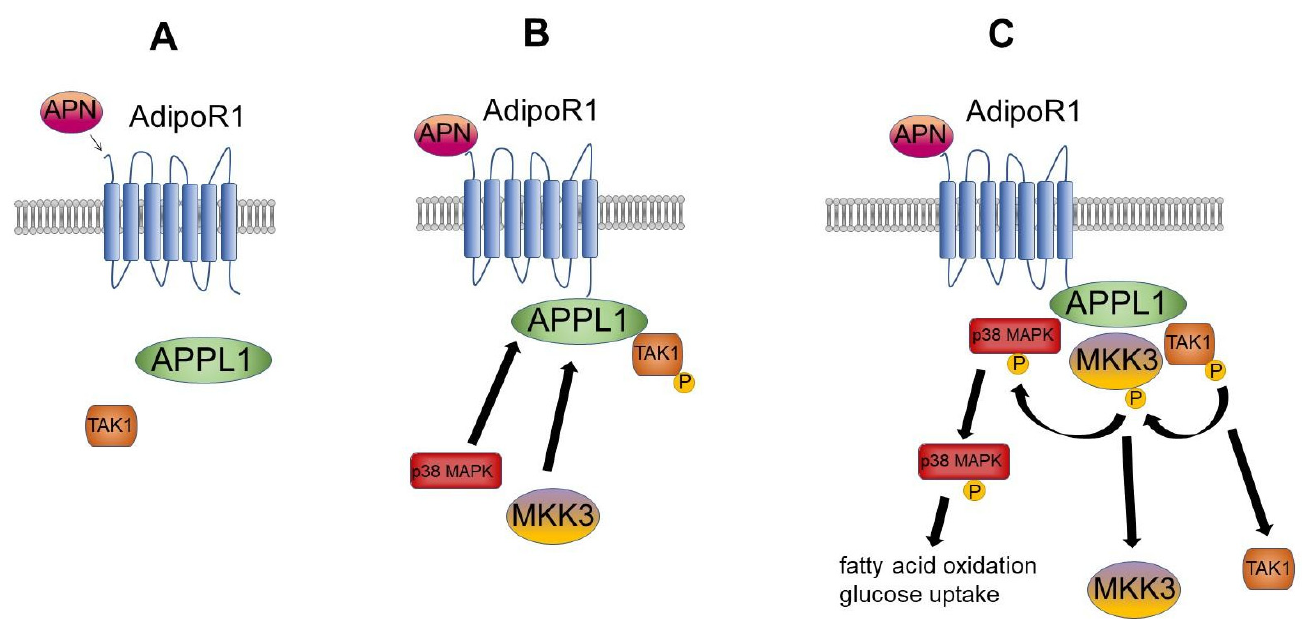
Figure 2. Mechanism of adiponectin-dependent MAPK activation. ( A ) In the non-stimulated state, adaptor protein containing pleckstrin homology domain, phosphotyrosine binding domain, and leucine zipper motif (APPL1) weakly interacts with transforming growth factor- β -activated kinase 1 (TAK1). ( B ) Upon adiponectin (APN) binding to the adiponectin receptor 1 (AdipoR1), APPL1 and phosphorylated TAK1 are recruited to the receptor site. This triggers the recruitment of two further proteins: p38 mitogen-activated protein kinase (p38 MAPK) and mitogen-activated protein kinase kinase 3 (MKK3). ( C ) TAK1 phosphorylates MKK3 and dissociates from the complex. MKK3 phosphorylates p38 MAPK, and both proteins dissociate from the complex. Phosphorylated p38 MAPK subsequently induces fatty acid oxidation and glucose uptake.